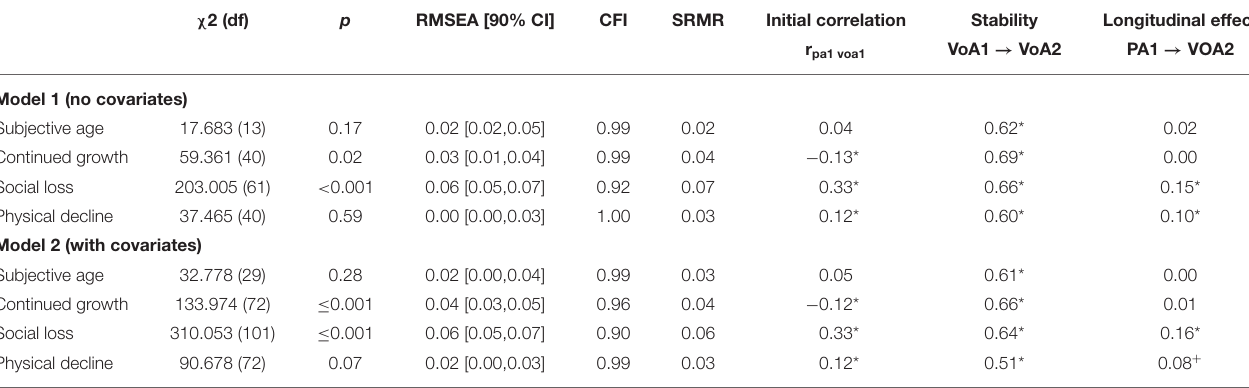
TABLE 2 | Model fits and standardized estimates of latent longitudinal structural equation models predicting views on aging at the second measurement occasion by perceived ageism at the first measurement